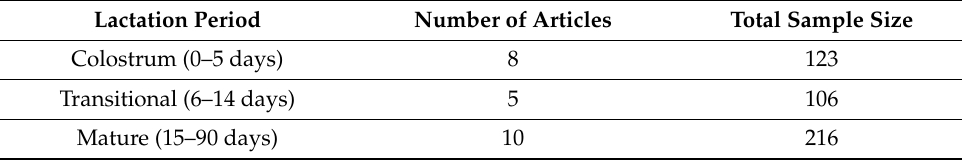
Table 5. Overview of reported data for total HMOs per lactation period. Lactation Period Number of Articles Total Sample